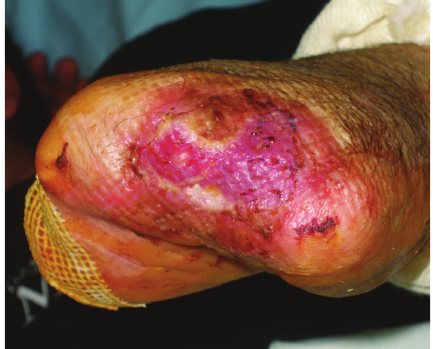
Figure 7: Full acception of the skin graft one week after transplan-